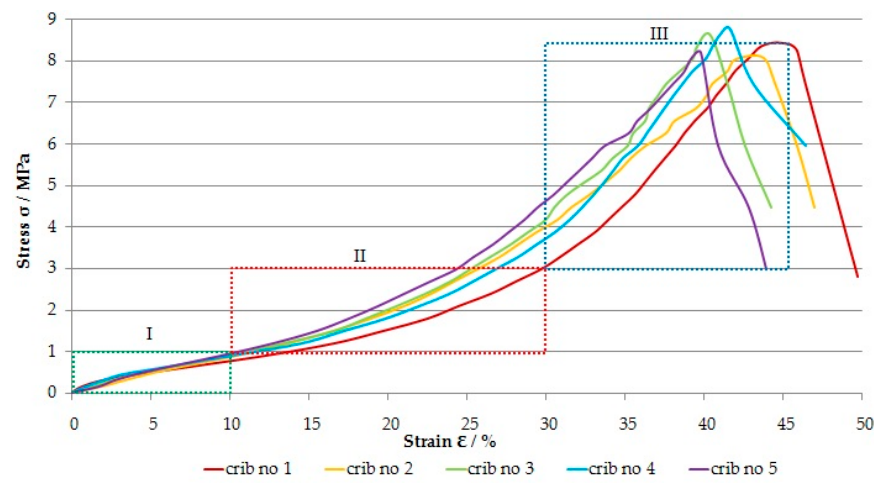
Figure 10. Stress-strain characteristics of the wooden crib models filled with waste rocks.